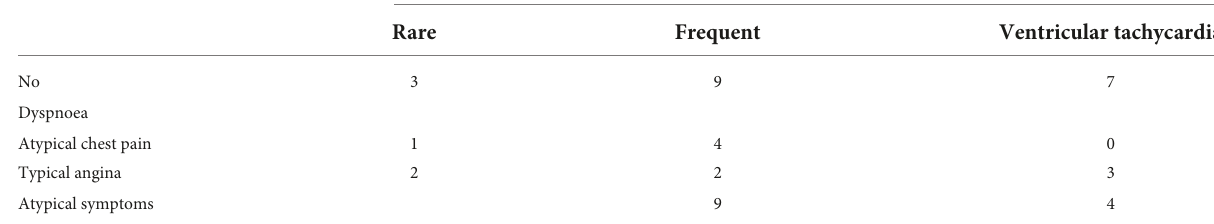
TABLE 4 (A) Correlation between symptoms and ECG changes suggestive of ischemia. (B) Correlation between symptoms and ventricular arrhytmias. (A) Ischemic-like symptoms ECG signs of ischemia No ST segment elevation ST segment depression Negative T waves No 8 19 14 7 Dyspnoea 2 2 Atypical chest pain 17 3 Typical angina 6 23 1 1 Atypical symptoms 4 1 2 (B) Symptoms Ventricular arrhythmias Rare Frequent Ventricular tachycardia No 3 9 7 Dyspnoea Atypical chest pain 1 4 0 Typical angina 2 2 3 Atypical symptoms 9